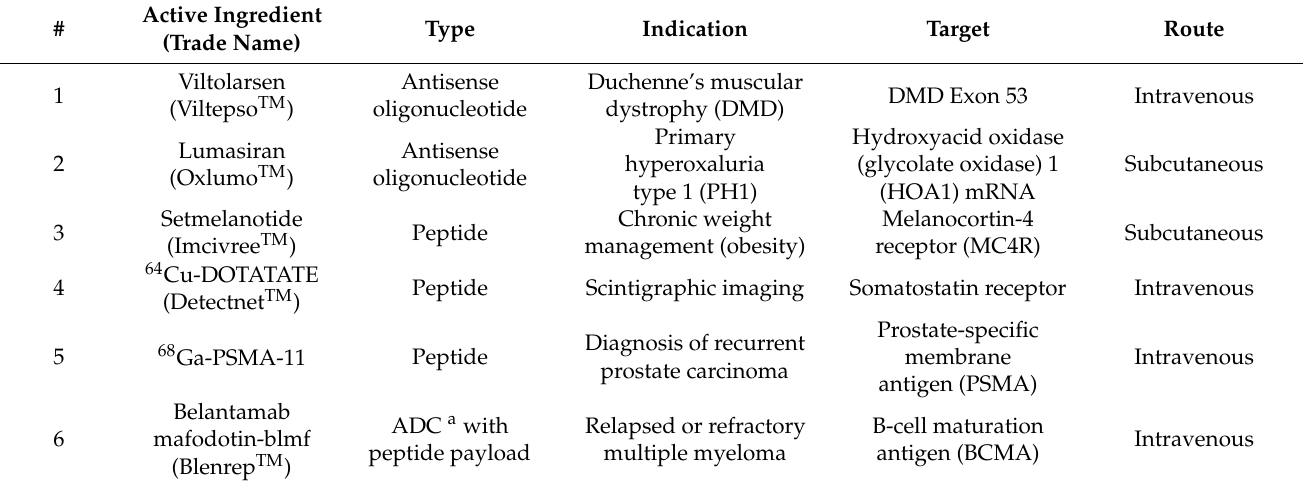
Table 1. Summary of the 2020 FDA peptides and oligonucleotides (TIDES) harvest.